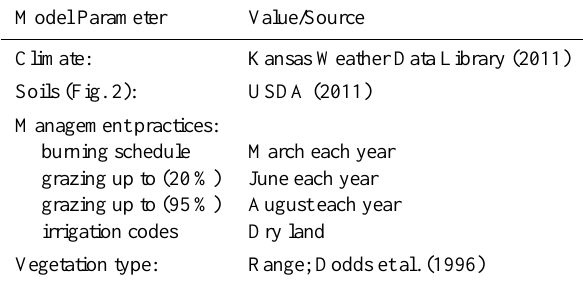
Table 2. Hydrogeology model parameters